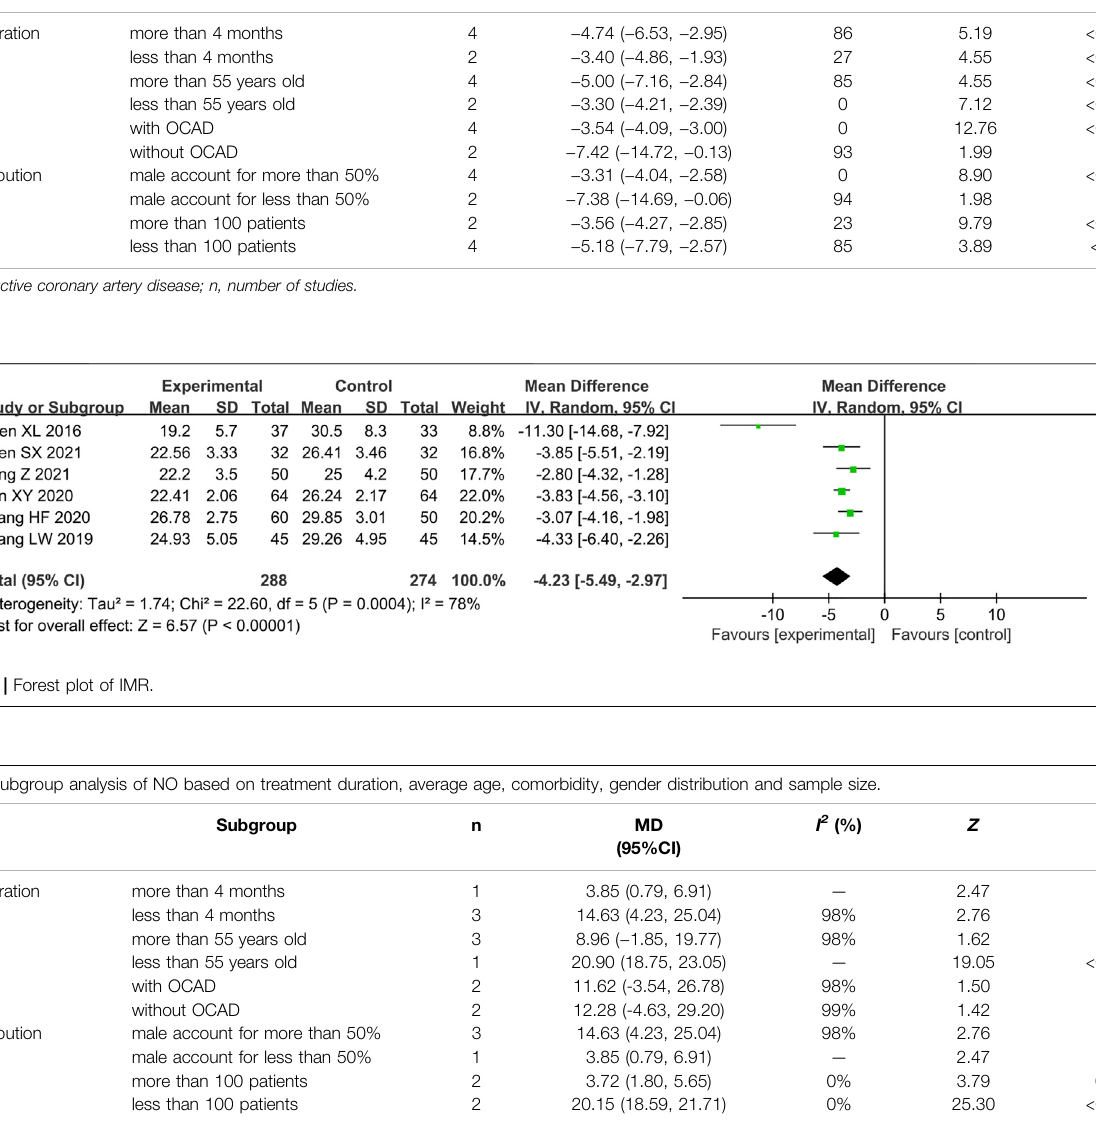
TABLE 3 | Subgroup analysis of IMR based on treatment duration, average age, comorbidity, gender distribution and sample size. Criteria for grouping